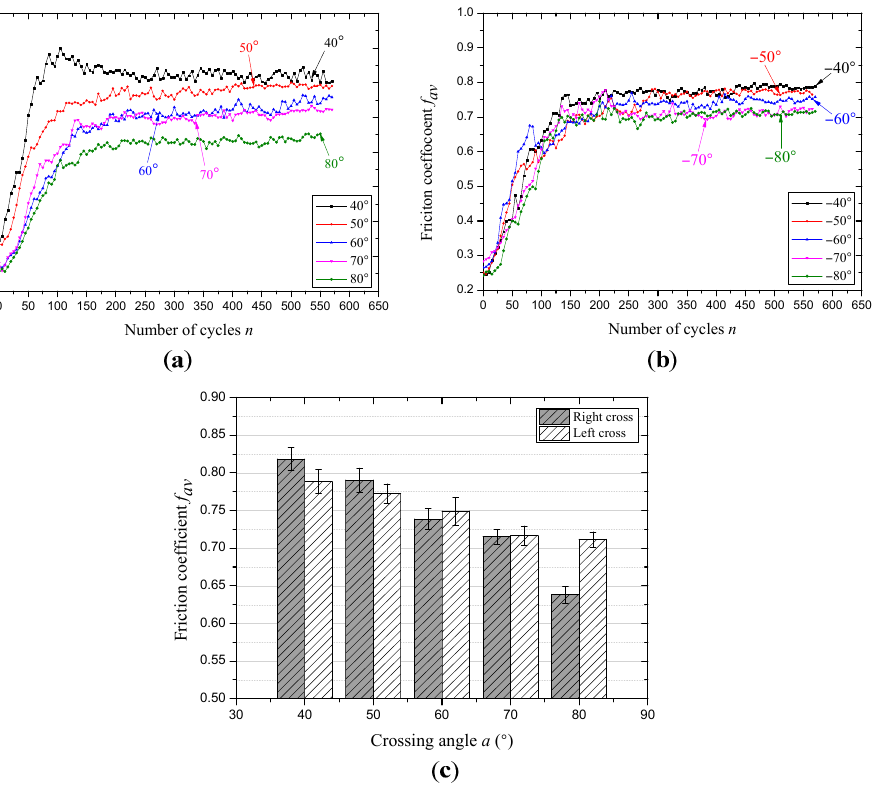
Figure 6. The evolution of friction coefficient under different sliding conditions ( x : 20 mm; v : 12 mm/s). ( a ) Right cross contact; ( b ) left cross contact and ( c ) the average values of the friction coefficient in the steady-state period.